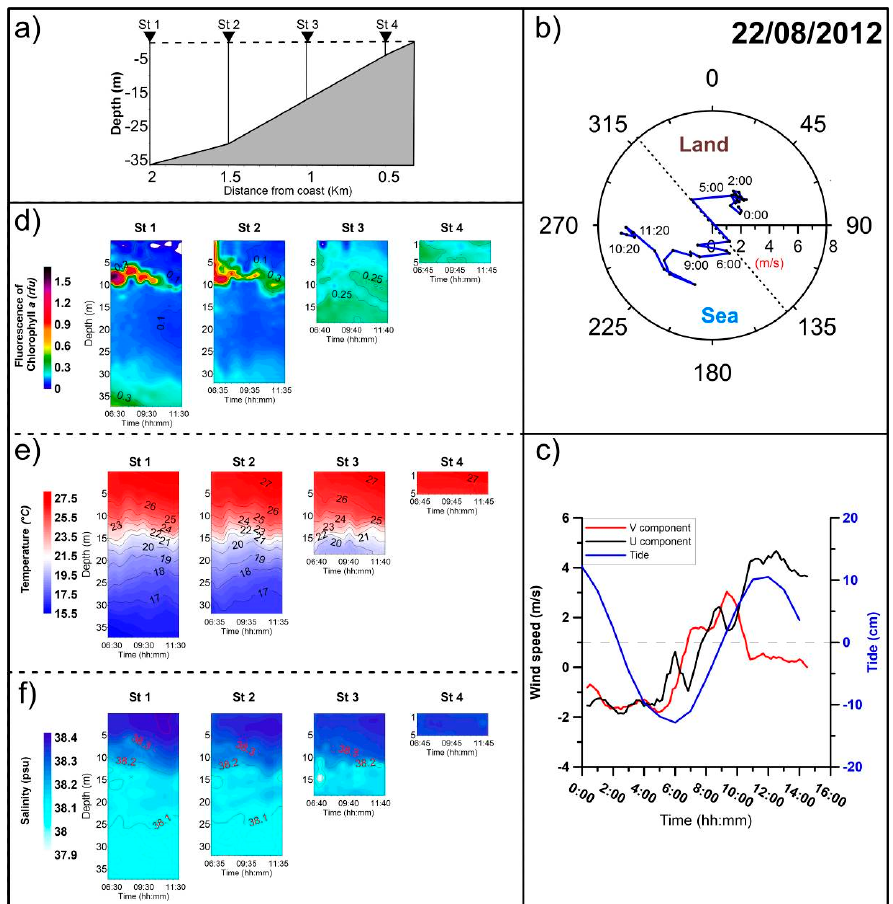
Figure 4. ( a ) Station location scheme along the transect survey. ( b ) Wind hodograph and ( c ) U (black line) and V (red line) wind components and tide (blue line) on the survey day. ( d ) Time series of chlorophyll a fluorescence, ( e ) temperature, and ( f ) salinity at all stations.